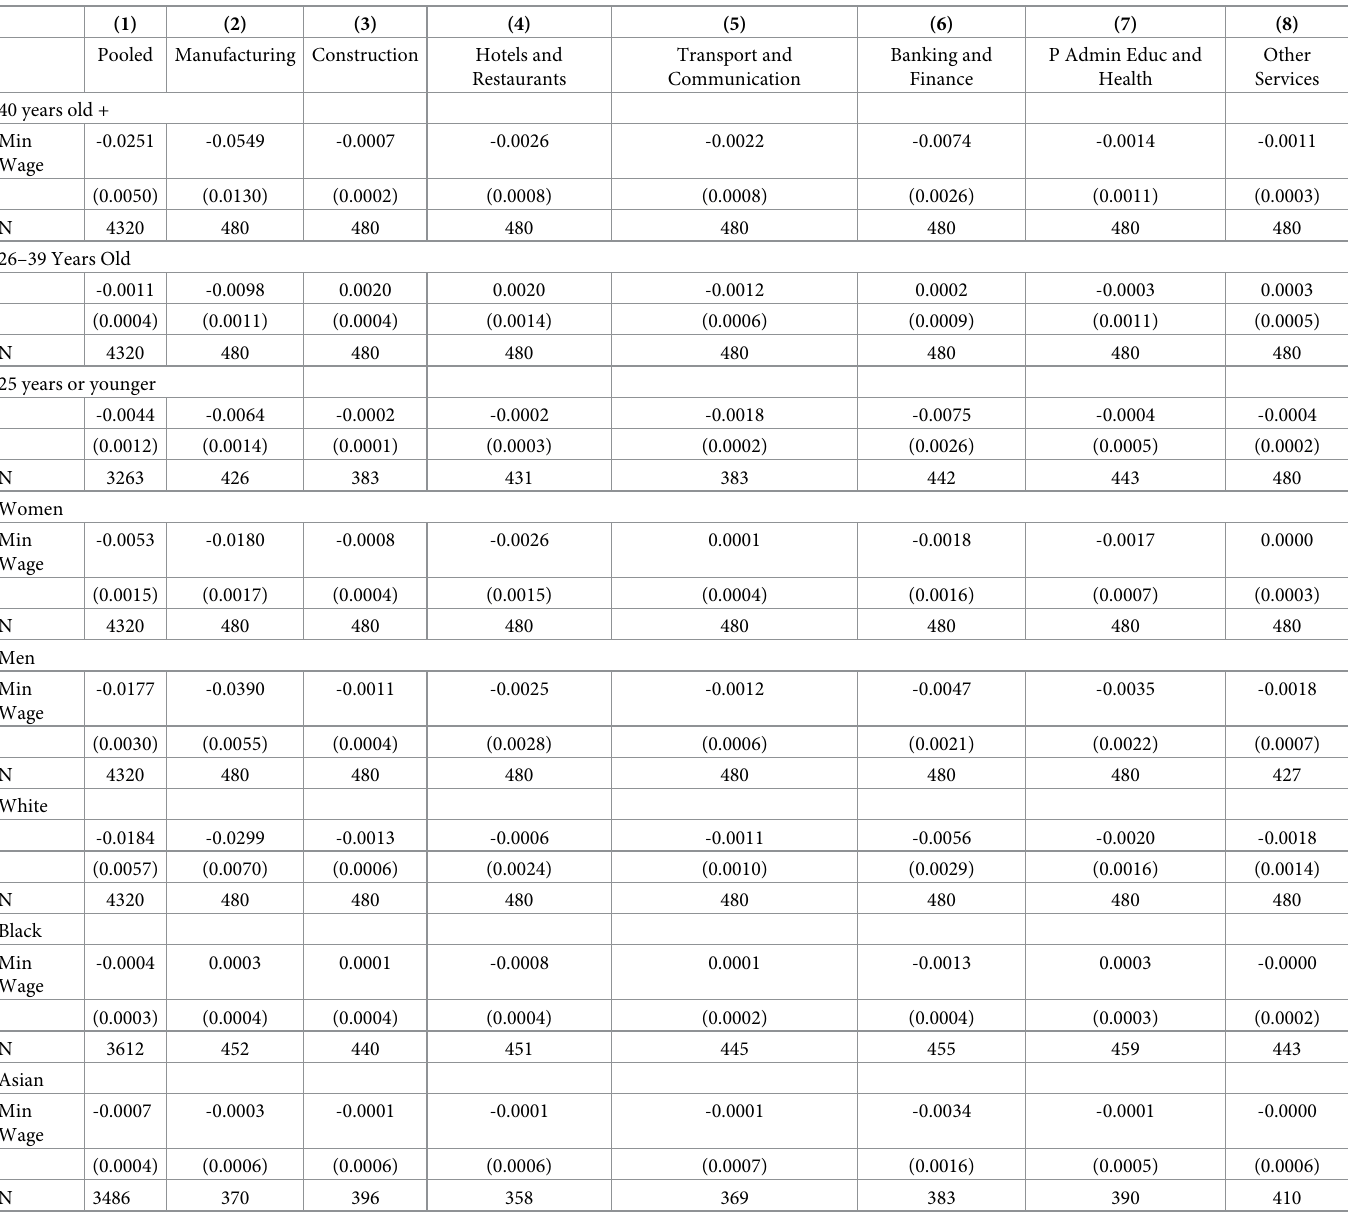
Table 3. Shares of employment